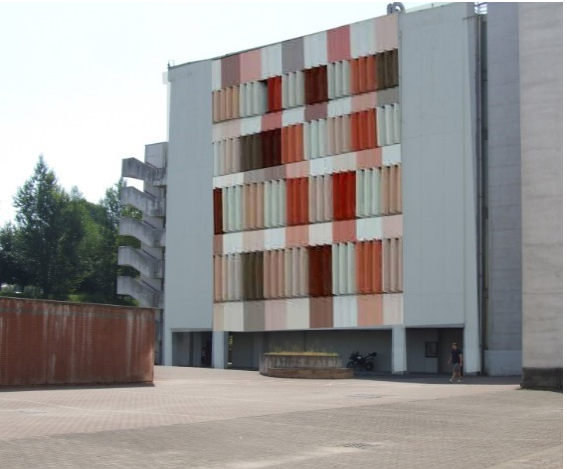
Figure 8. Sunblind system applied to west-facing façade—main building 6. The colored closures have a variegated color spectrum that can be used to identify the external façades, and thus, facilitate orientation within the